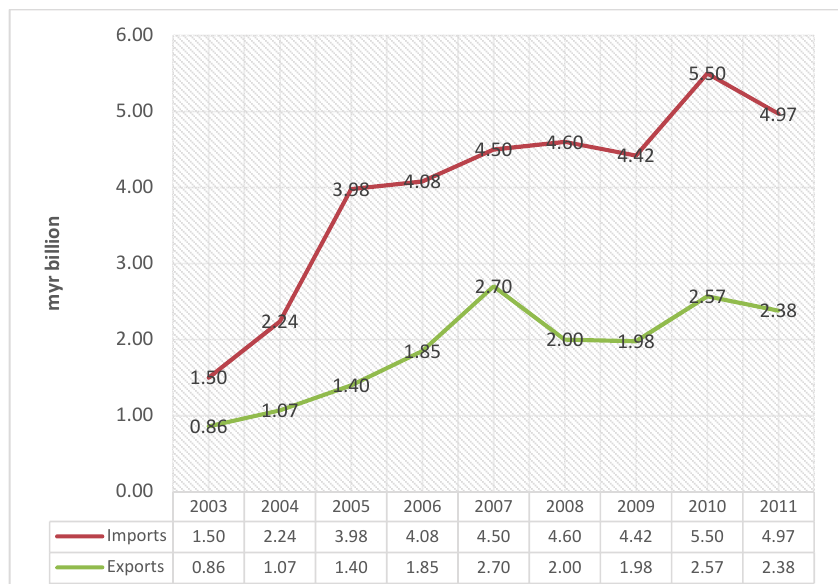
Fig. 1. Import and export values of Malaysia automotive components. (Source: ASEAN Secretariat